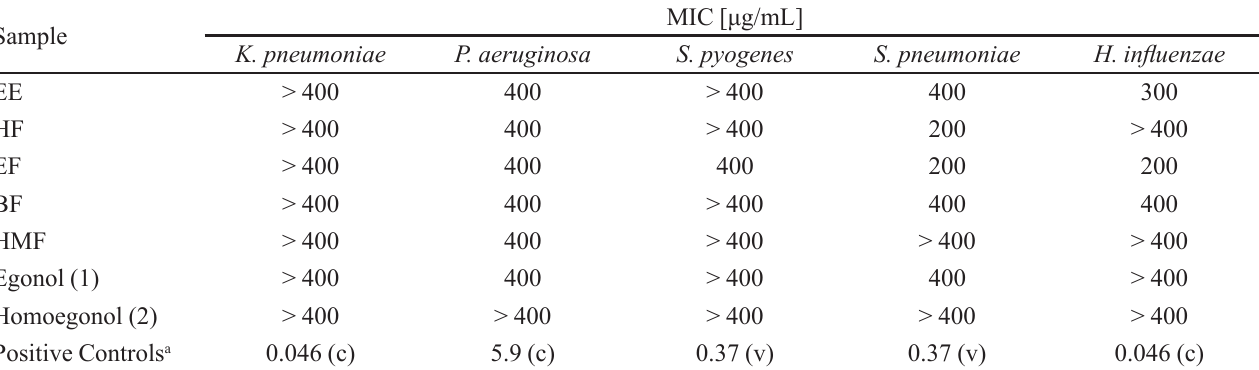
TABLE I - Minimum inhibitory concentration values (MIC) obtained for the crude ethanolic extract of S. pohlii , fractions and isolated